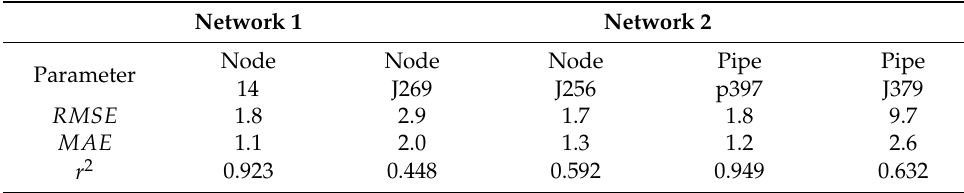
Table 3. Evaluation parameters of the T-GCN model in pressure and flow rate. Network 1